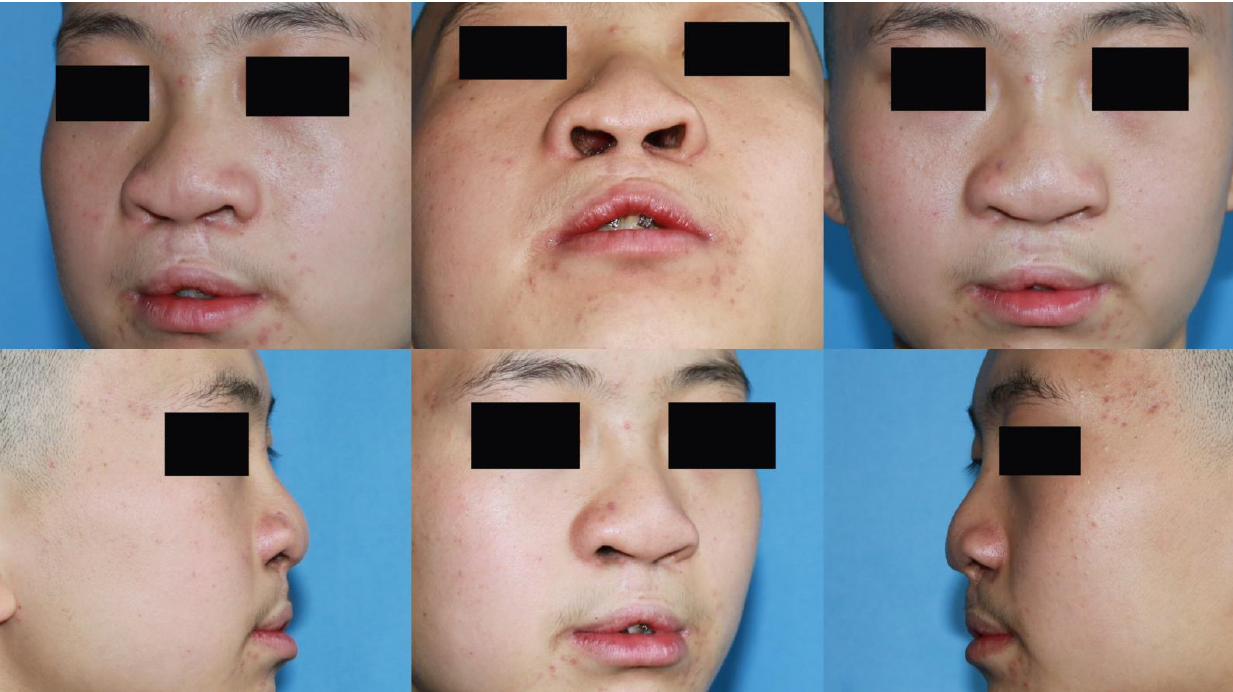
Figure 6. A 25-year-old male presented with cleft lip nasal deformity before our surgery. The photos were taken before the operation.